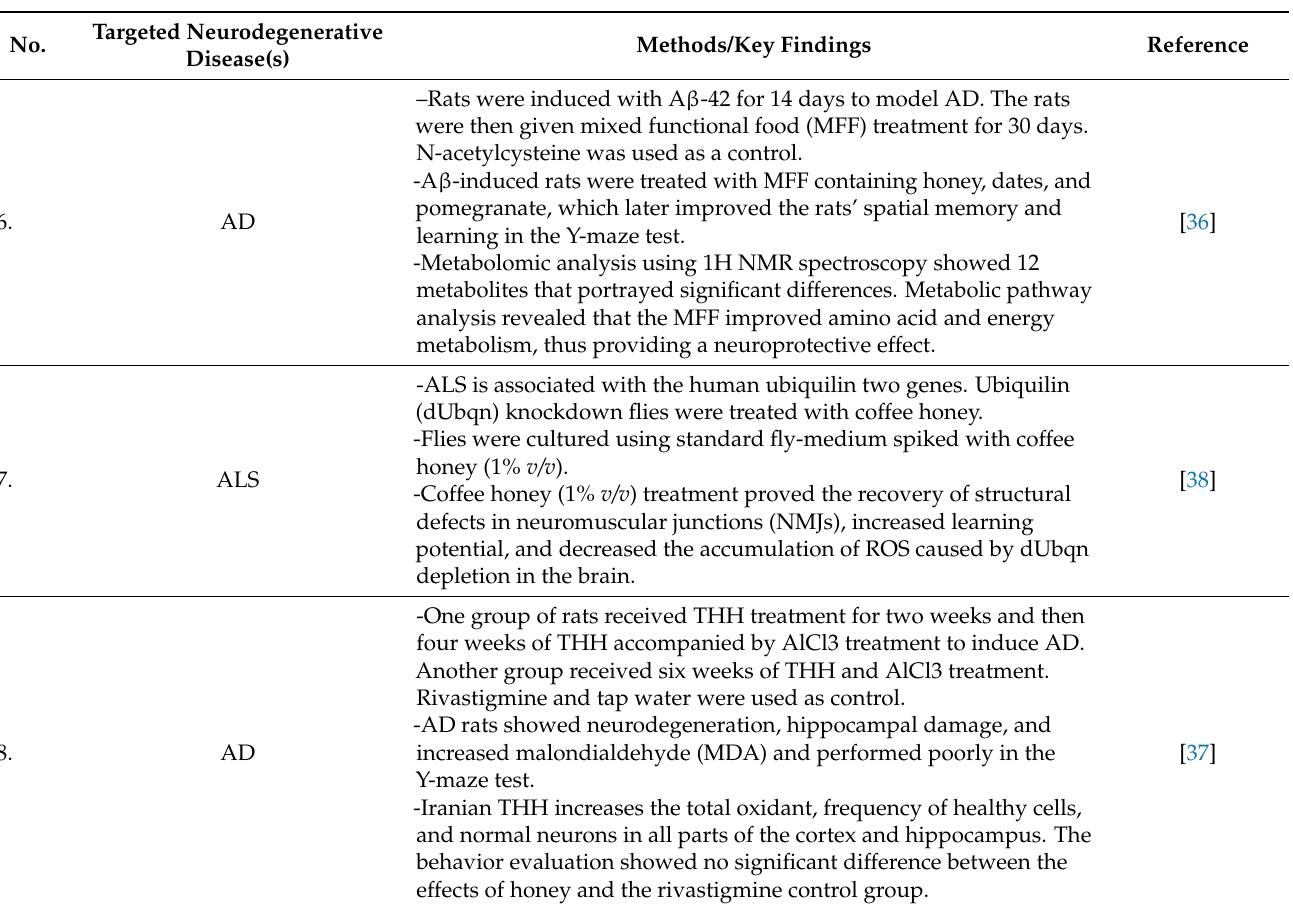
Table 3. A study using in vitro and in vivo on honey to treat neurodegenerative diseases. No. Disease(s)